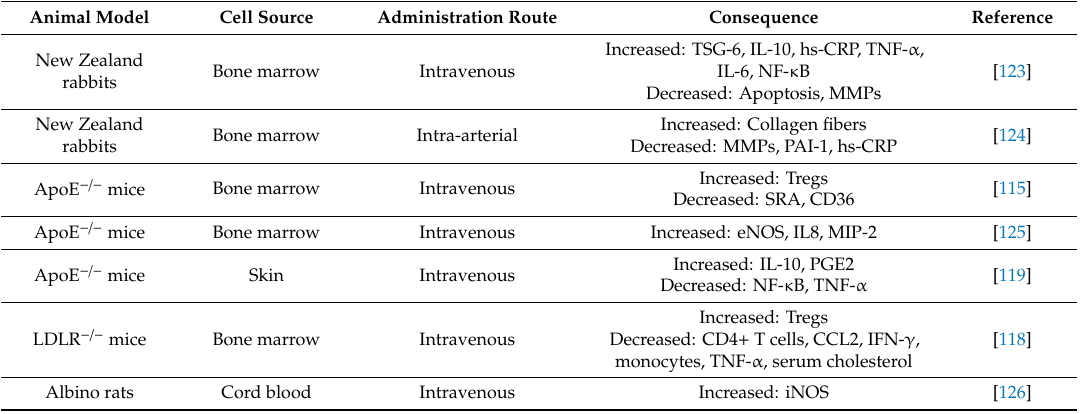
Table 1. Animal studies exploring the therapeutic potential of mesenchymal stem cells in the treatment of